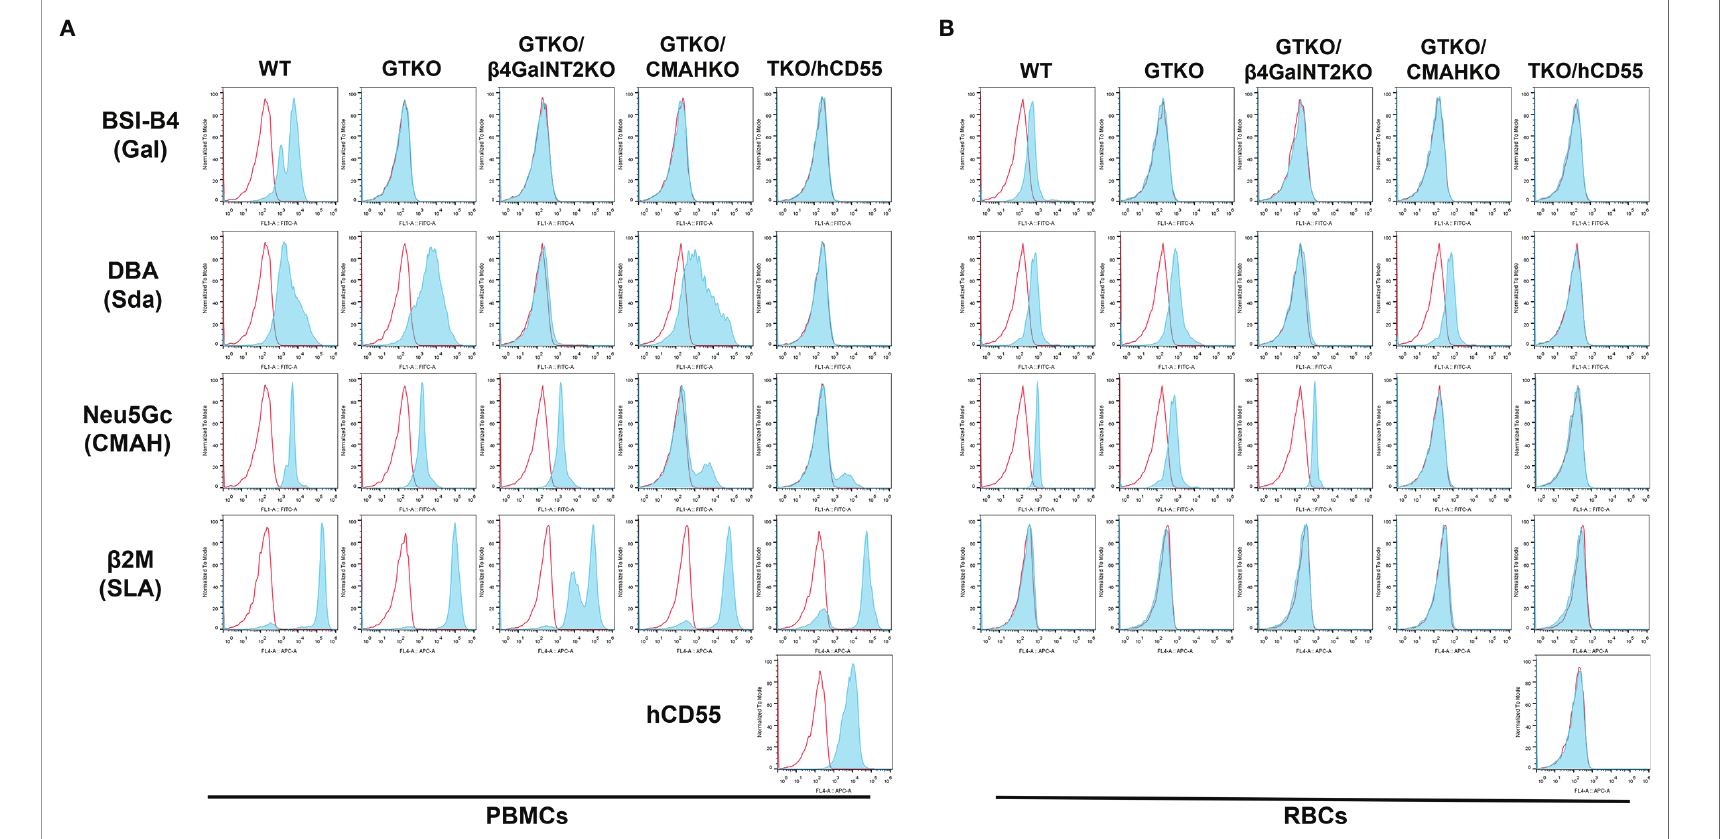
FIGURE 1 | Expression of Gal, Sda, Neu5Gc, SLA, and hCD55 on WT, GTKO, GTKO/ b 4GalNT2KO, GTKO/CMAHKO and TKO/hCD55 pig PBMCs and RBCs by fl ow cytometry. (A) PBMCs and (B) RBCs from WT pigs expressed Gal, Sda, and Neu5Gc. GTKO expressed Sda and Neu5Gc. GTKO/ b 4GalNT2KO expressed Neu5Gc. GTKO/CMAHKO expressed Sda. TKO/hCD55 PBMCs (but not RBCs) expressed hCD55. All PBMCs expressed SLA, but RBCs did not express